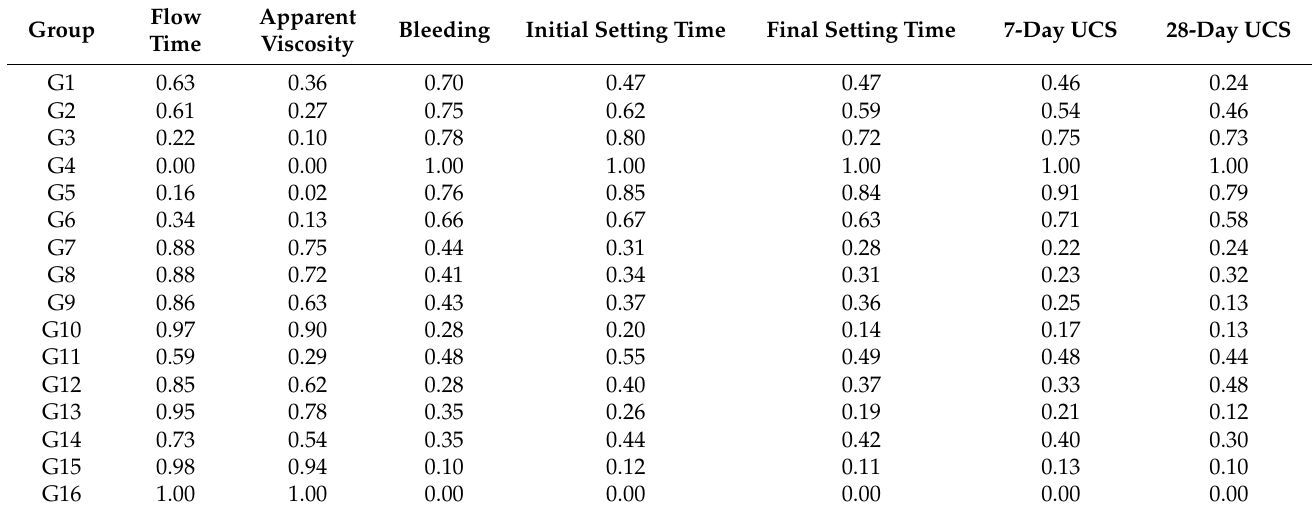
Table 8. Normalized values of different properties of the UC-based slurry.